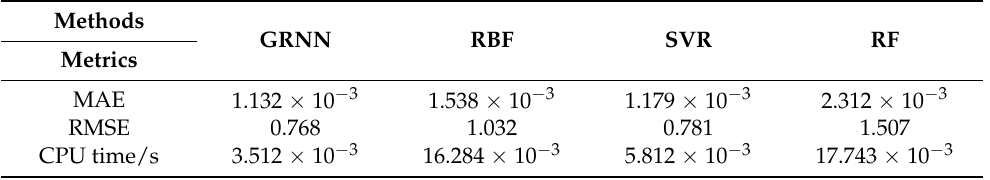
Figure 12. Prediction output of different models based on verification data. Table 4. The prediction results under verification data.